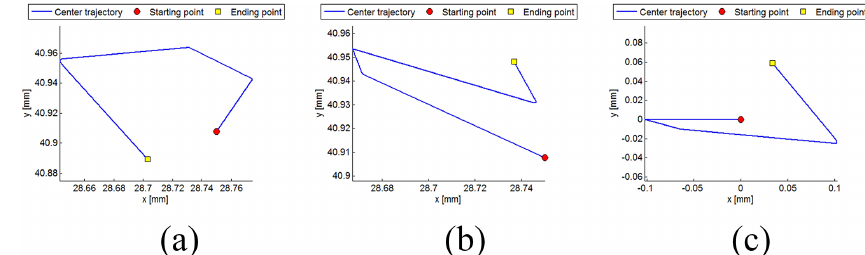
Figure 13. Center trajectories of the journal and bearing.